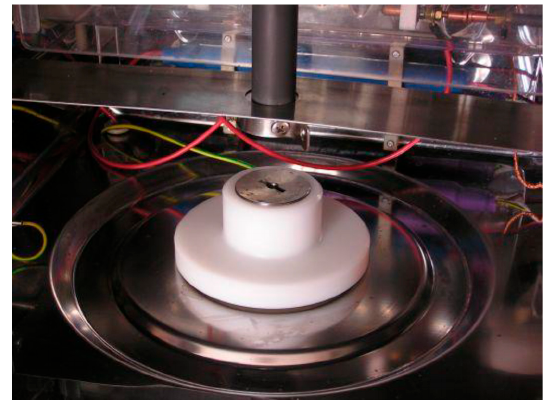
Figure 3. Stationary cell located inside the pulsed electric field (PEF) conditioning chamber.